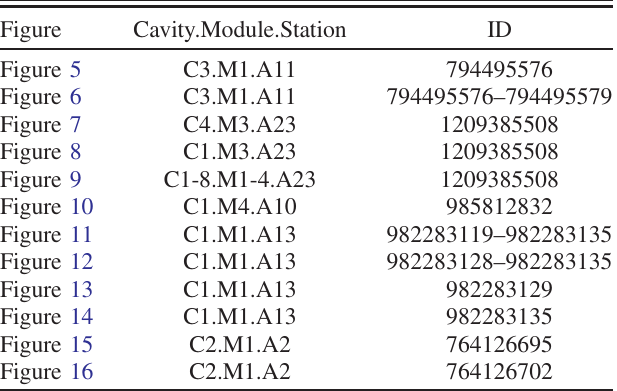
Cavity.Module.Station